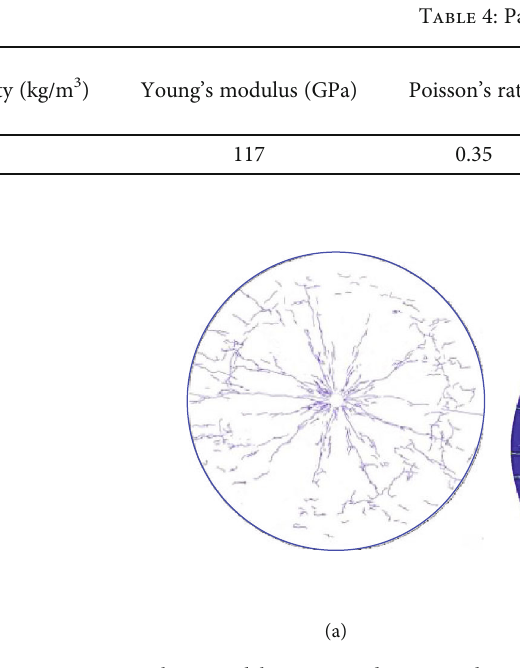
Figure 5: Comparison between laboratory and numerical results on fracture development due to blasting: (a) laboratory results; (b) numerical results.